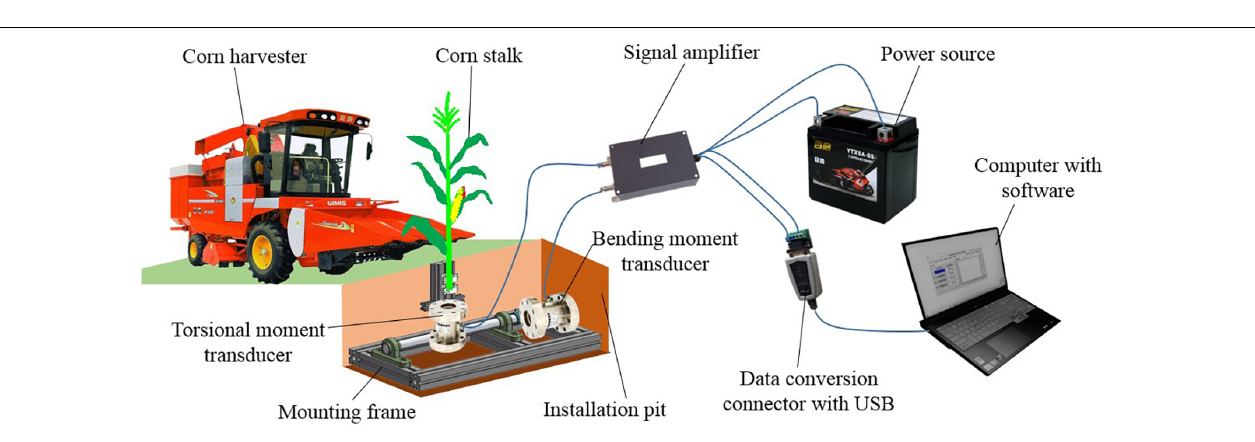
FIGURE 3 | An experiment of forces on stalks in corn harvesting. (A) Experiment on the upright corn; (B) experiment on the lodged corn; (C) the experiment scene of corn harvest.